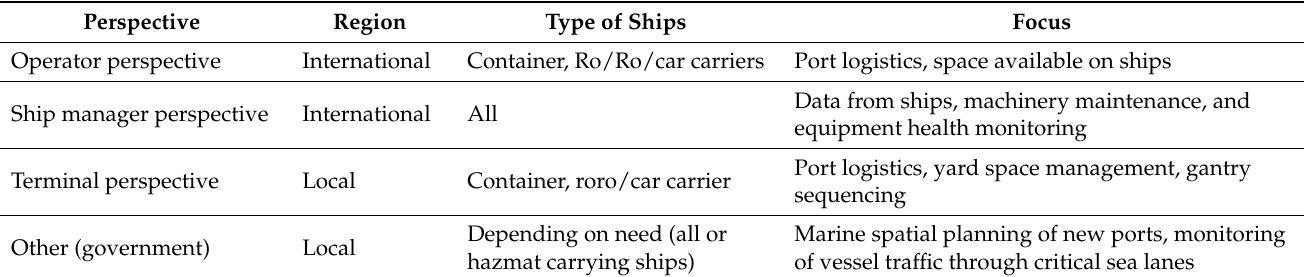
Table 2. Uses of big data analytics in shipping (Source: the